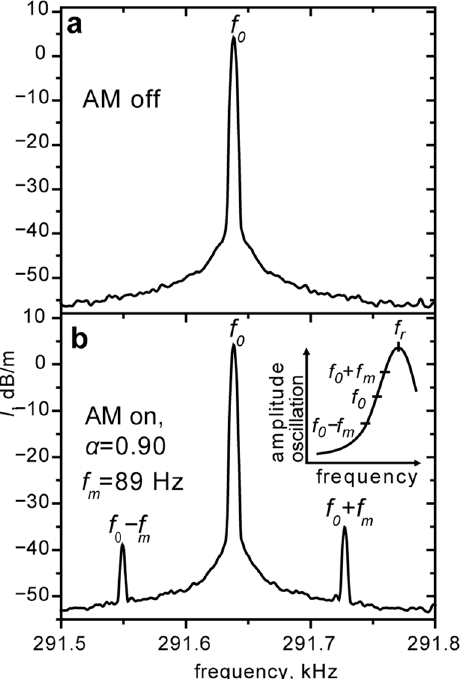
Figure 2. Spectra of cantilever oscillation in the 100 MHz magnetic field generated by writing head without ( a ) and with ( b ) amplitude modulation. Inset shows the scheme of the cantilever oscillation f 0 , resonance f r and magnetic sideband f 0 ± f m frequencies on amplitude frequency